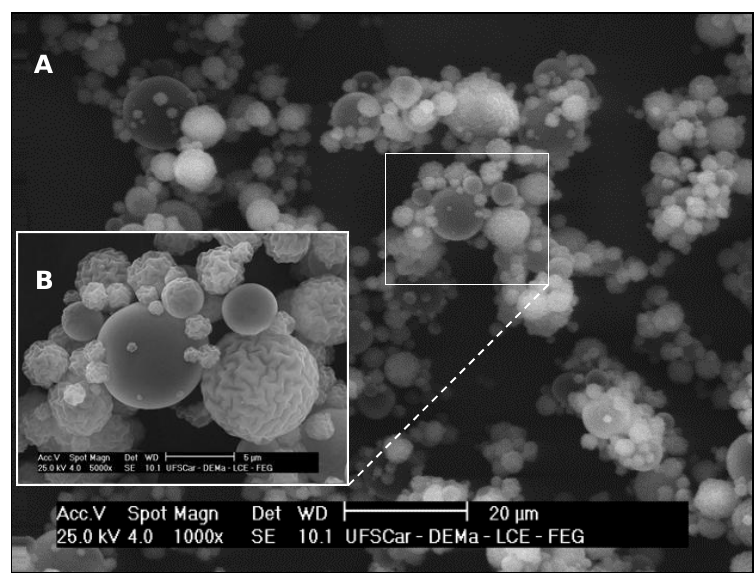
Figure 2. Scanning electron microscopy images of spray-dried chitosan microparticles. ( A ) 1000× and ( B ) 5000× magnification.